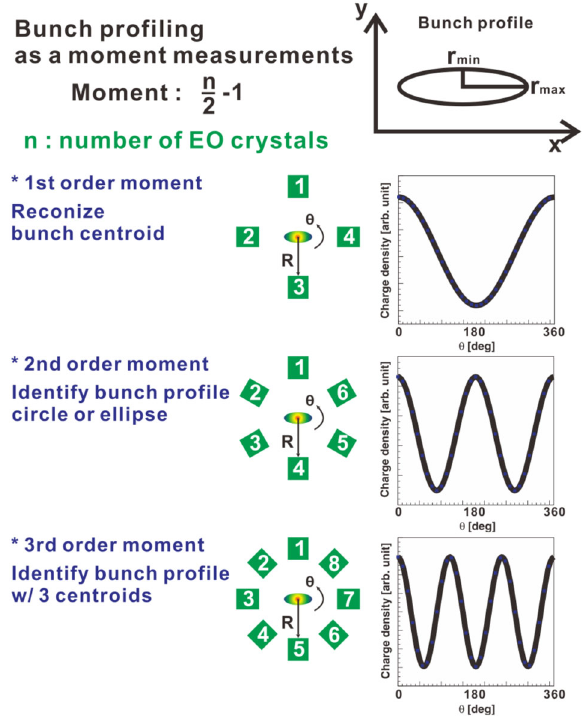
FIG. 2. Transverse bunch profiling as moment